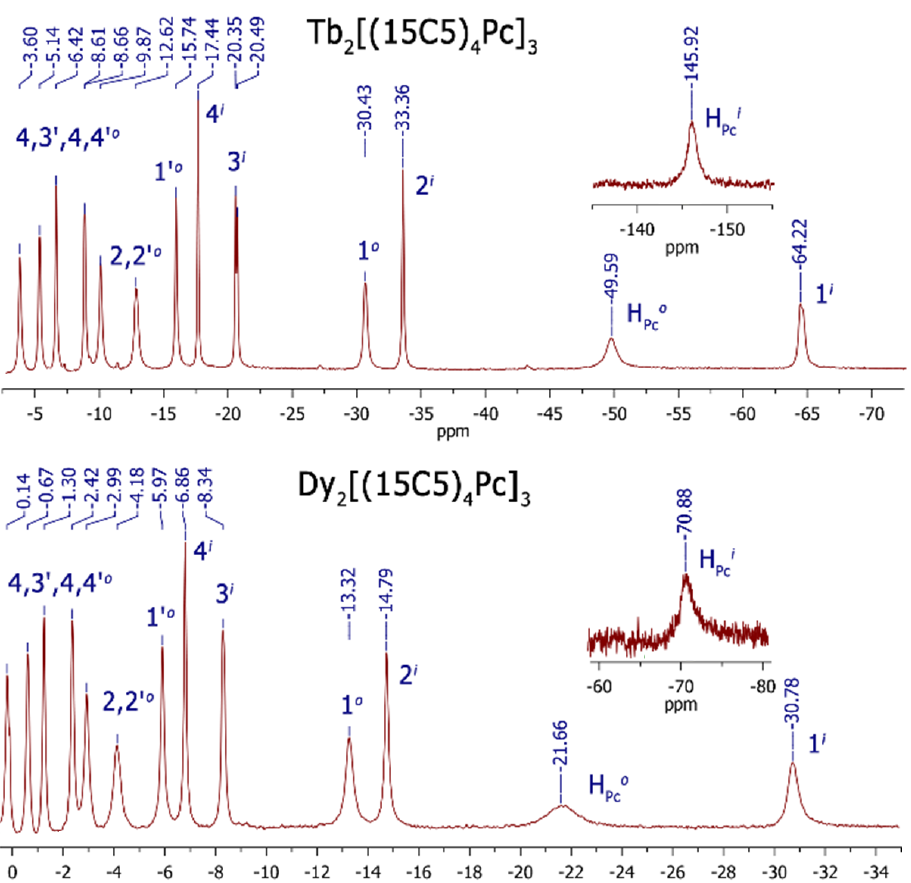
Figure 2. 1 H NMR spectra of Ln 2 [(15C5) 4 Pc] 3 (where Ln = Tb, Dy) measured in CDCl 3 at 303 K.